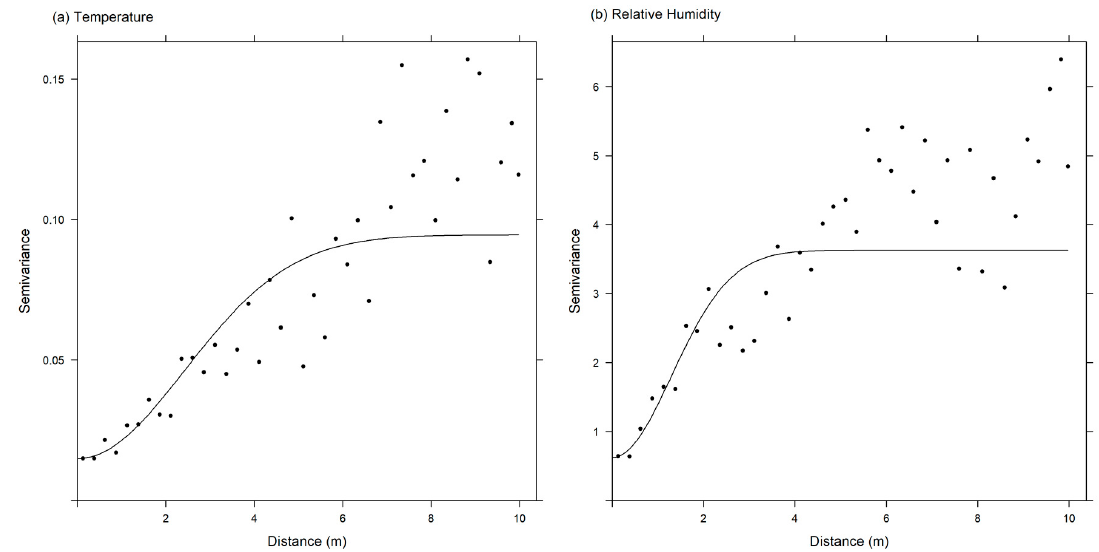
Figure 5. Sample variograms with Gaussian variogram models fitted to ( a ) temperature and ( b ) relative humidity data from flight A3 on June 29.